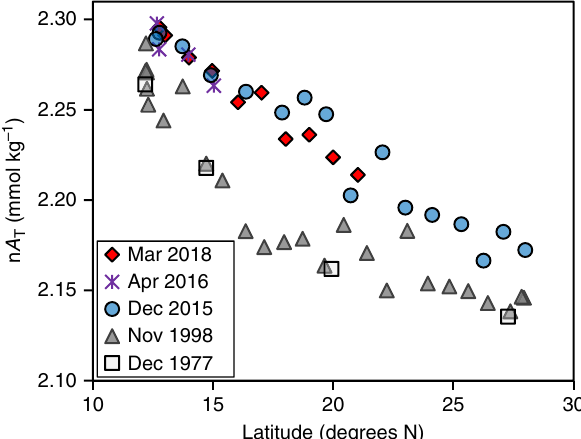
Fig. 2 Total alkalinity normalized to salinity of 35 (nA T ) in the Red Sea and Gulf of Aden (West of 48°E). Analytical uncertainties in the present and previous studies 24,35 are smaller than the symbol